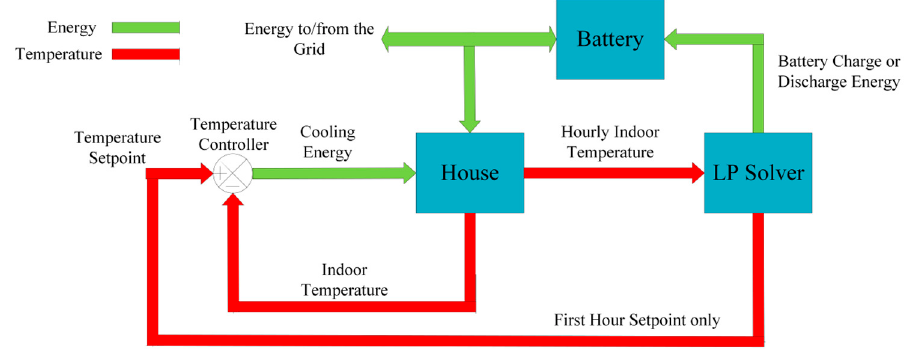
Figure 4. Smart house operation flowchart.